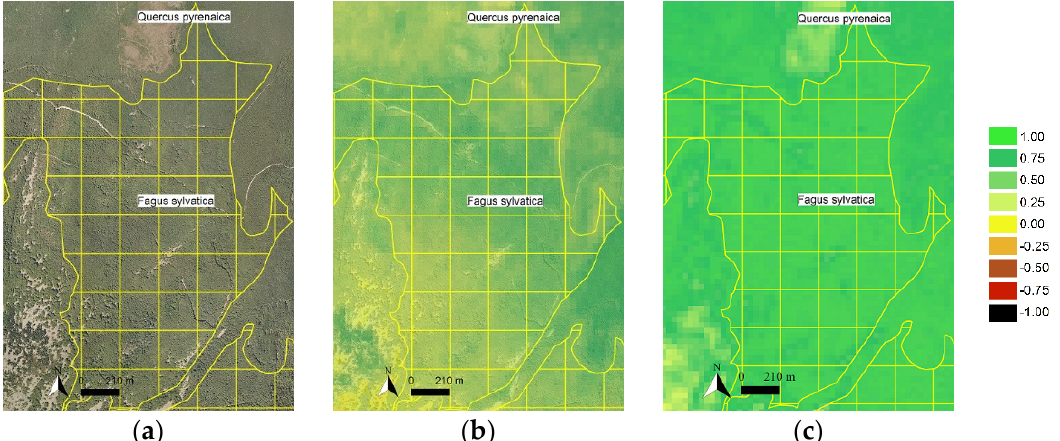
Figure 7. An example of a mislabelled polygon, depicted in yellow over the orthophotography ( a ), 28 April 2001 NDVI ( b ) and 25 July 2001 NDVI ( c ).